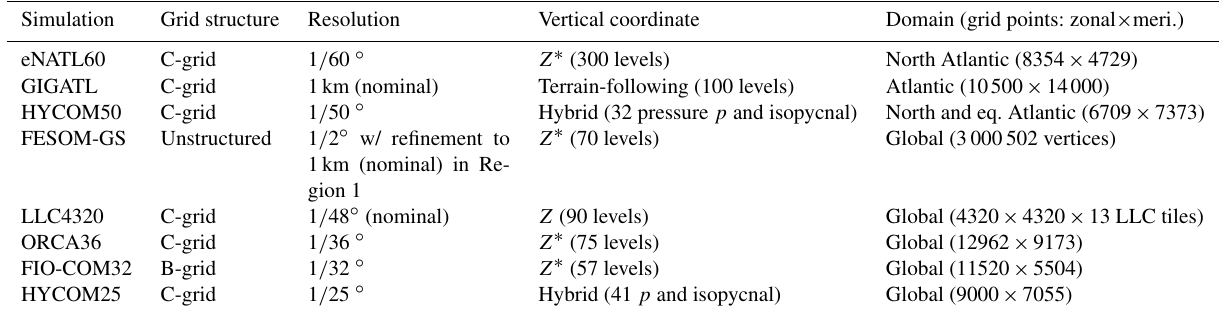
Table B2. The horizontal and vertical native coordinate system, spatial resolution, and domain coverage for each simulation. The Z ∗ ver- tical coordinate is the rescaled geopotential coordinate where the fluctuations of the free surface are taken into account (cf. Griffies et al., 2016). Note that vertical resolution as well as horizontal resolution vary significantly between the models. Outputs from FESOM-GS were interpolated onto a Cartesian grid offline with a cubic